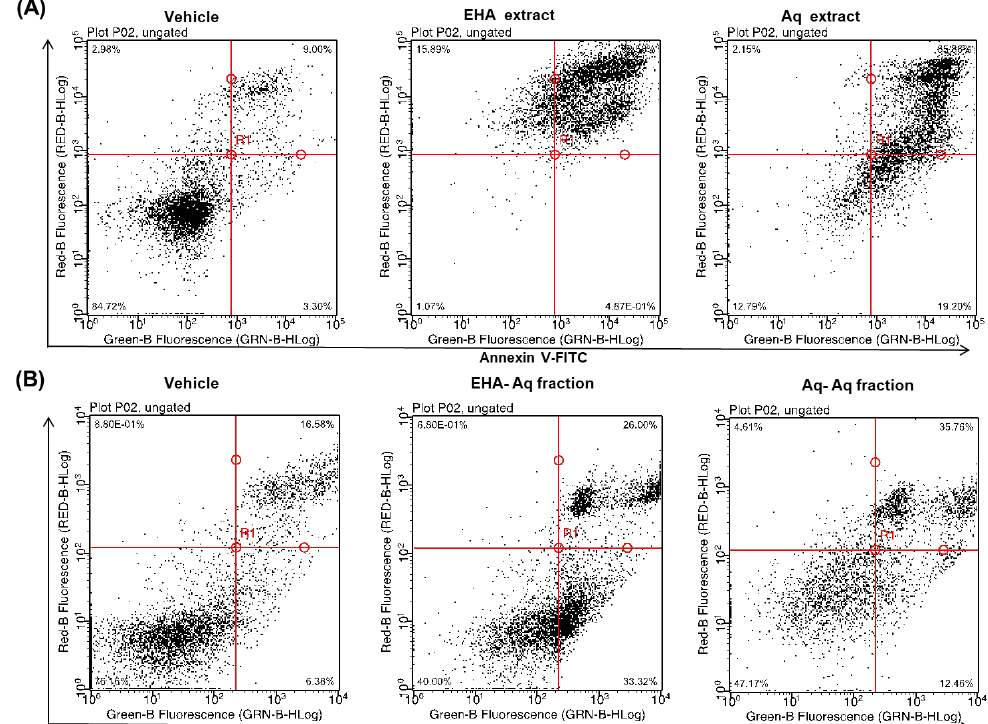
Figure 1. Apoptosis induction by crude extracts (EHA and Aq, 100 μg/mL ) after 24 h ( A ), as well as the corresponding aqueous fractions (EHA-Aq and Aq-Aq, 100 µg/mL) ( B ) of Antiaris africana Engler leaf extracts in MCF-7 cells compared with the control test . Lower-left quadrant — viable cells; lower- right — early apoptotic cells; upper-right — late apoptotic cells; upper-left — necrotic cells.